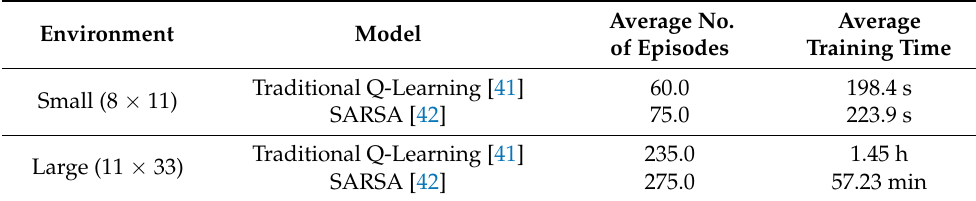
Table 3. The Relative Performance of Previous